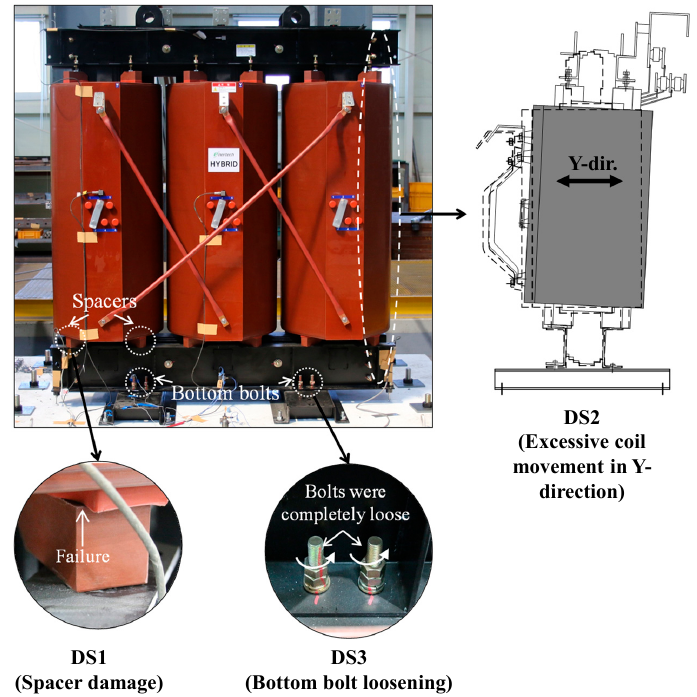
Figure 15. Critical damage states observed during the shaking table tests. Table 6. Values of limit states of the mold transformer.